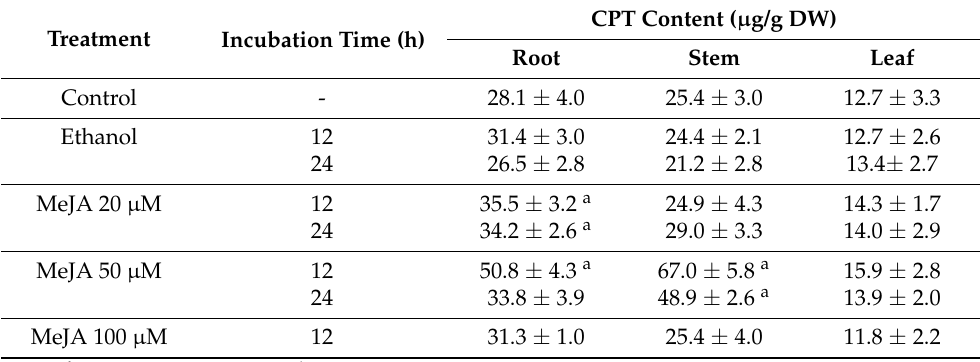
Figure 4. Effects of MeJA elicitation on CPT concentration in roots by elicitation with ethanol and MeJA (20, 50 and 100 µM) for 12 h (□) and 24 h ( ■ ) before harvesting. The values are expressed as mean ± SD ( n = 3); a: significant at p < 0.05 vs. control. 3.2.2. Stems Following 50 µM MeJA elicitation for 12 and 24 h, the CPT content in the stems of O. ridleyana increased significantly (Figure 5). The maximum CPT content in the stems in response to MeJA elicitation was increased by 2.6-fold (66.98 µg/g DW) and 1.9-fold (48.85 µg/g DW) after MeJA treatment for 12 and 24 h, respectively. No significant effect